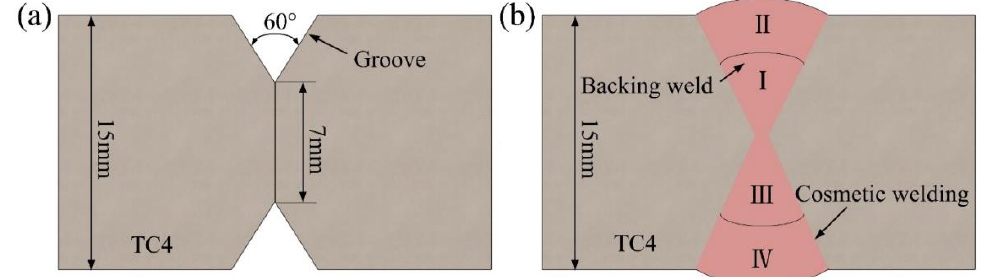
Figure 3. ( a ) Schematics of geometry sizes of laser-MIG hybrid (LAMIG)-welded TC4 joint; ( b ) schematic diagram of welding sequence and distribution of welding passes. Table 3. Backing weld parameters.